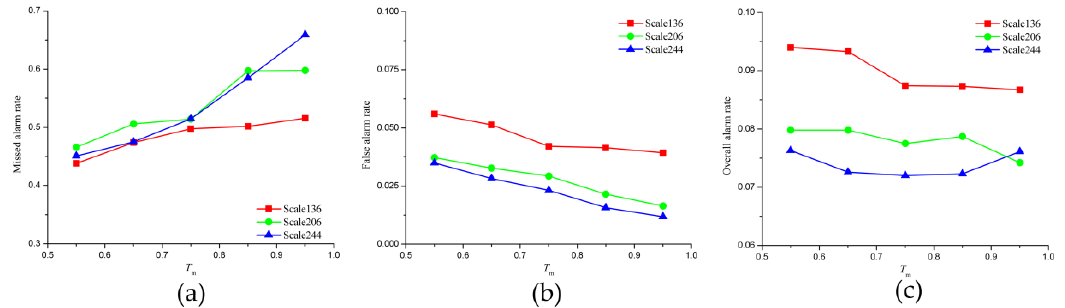
Figure 20. Influence of the uncertainty index threshold for DS2. ( a ) Missed alarm rate at various scales; ( b ) False alarm rate at various scales; ( c ) Overall alarm rate at various scales.